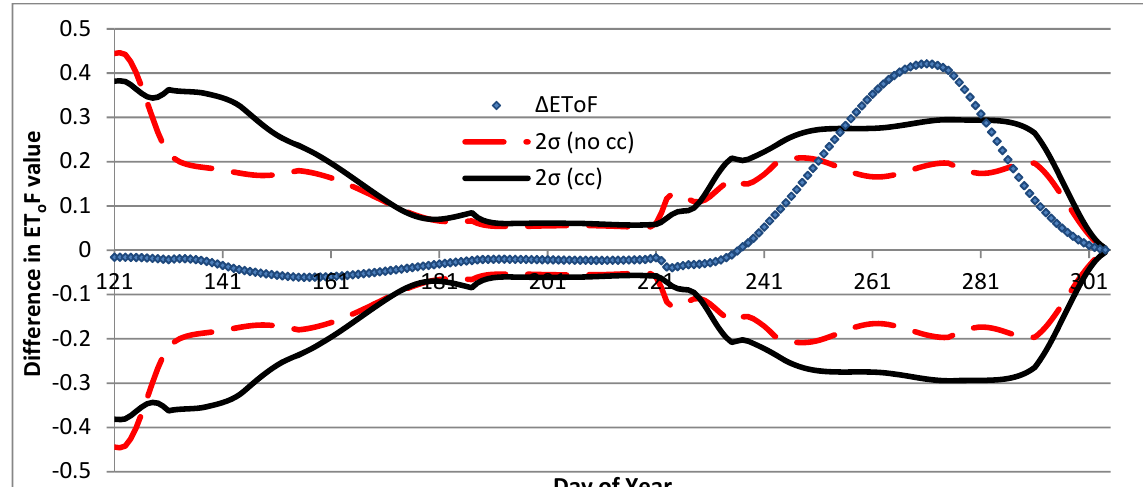
Figure 3. Difference between METRIC ET F values (unit-less) calculated for the fields o with cover crops and for the fields without cover crops. The blue points are the difference F values between fields with cover crops and fields without cover crops. The black in ET o lines represent two standard deviations from the combined mean of the fields with cover crops, and the red dashed lines represent two standard deviations from the combined mean of the fields without cover